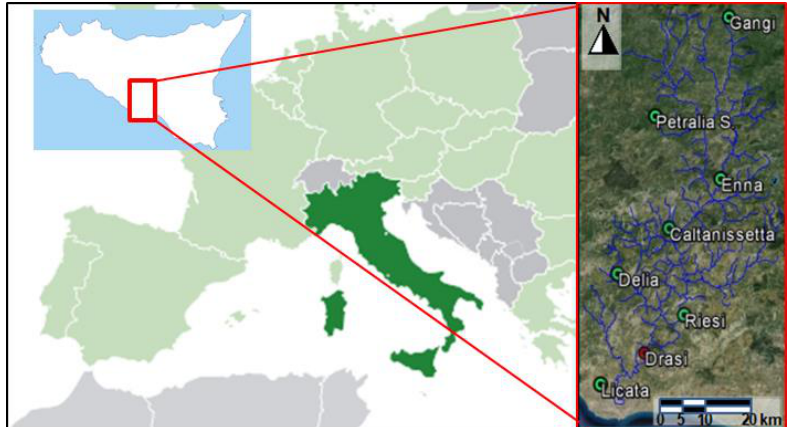
Figure 1. Location of the Imera Meridionale catchment (on the left , adapted from Wikimedia Commons, the free media repository) and the catchment river network (on the right , blue lines) and discharge and meteorological gauge stations (red and green dots, respectively).